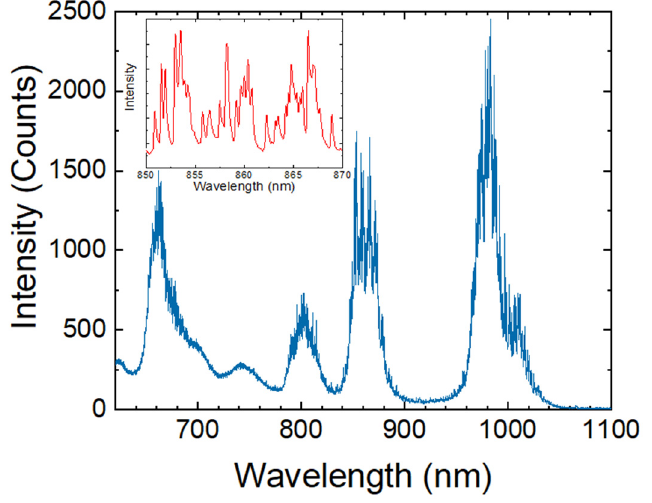
Figure 2. Emission spectrum of Er 3+ -doped BTS glass microsphere under a 532 nm excitation. Inset: Close up of the WGM resonant peaks in the 850 nm emission band.